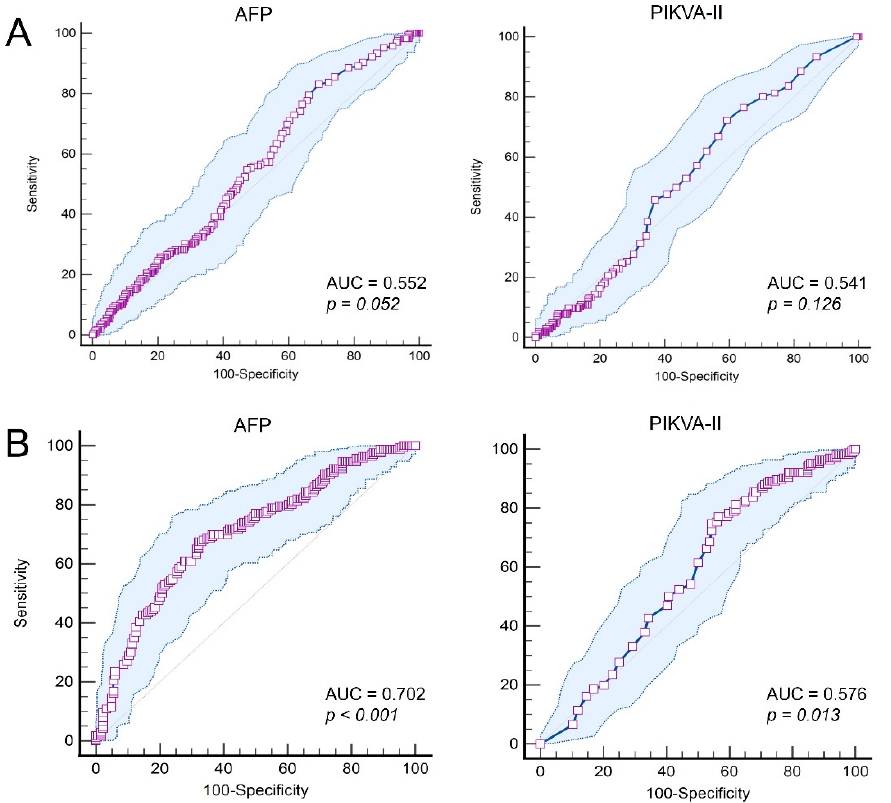
Figure 4. Receiver operating characteristic curve analysis of α -fetoprotein (AFP) and protein-induced by Vitamin K absence or antagonist-II (PIVKA-II) for predicting complete pathological response in the cohort of complete pathological response study patients and no-hepatocellular carcinoma patients ( A ) and the cohort of complete pathological response study patients and partial pathological response control patients ( B ). AUC, area under the curve.